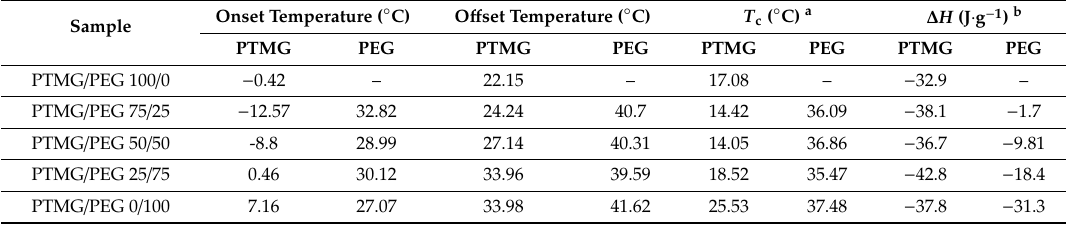
Figure 4. DSC of PTMG / PEG porous sca ff old materials. Table 1. Crystallization temperatures and enthalpies of PTMG / PEG sca ff